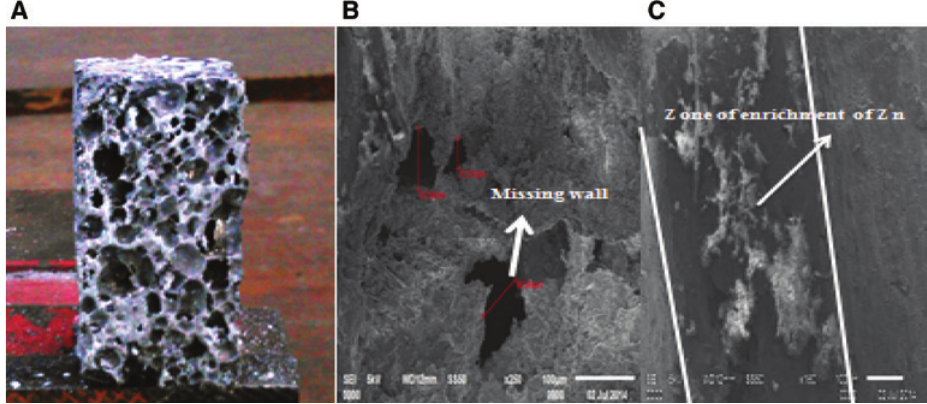
Figure 4 depict three regions: (i) elastic region, (ii) plateau region and (iii) densification region. The elastic limit shows linear deformation when strain is low. As the strain increases, from the curve it is clear that the stress remains almost constant in the region. At last stress